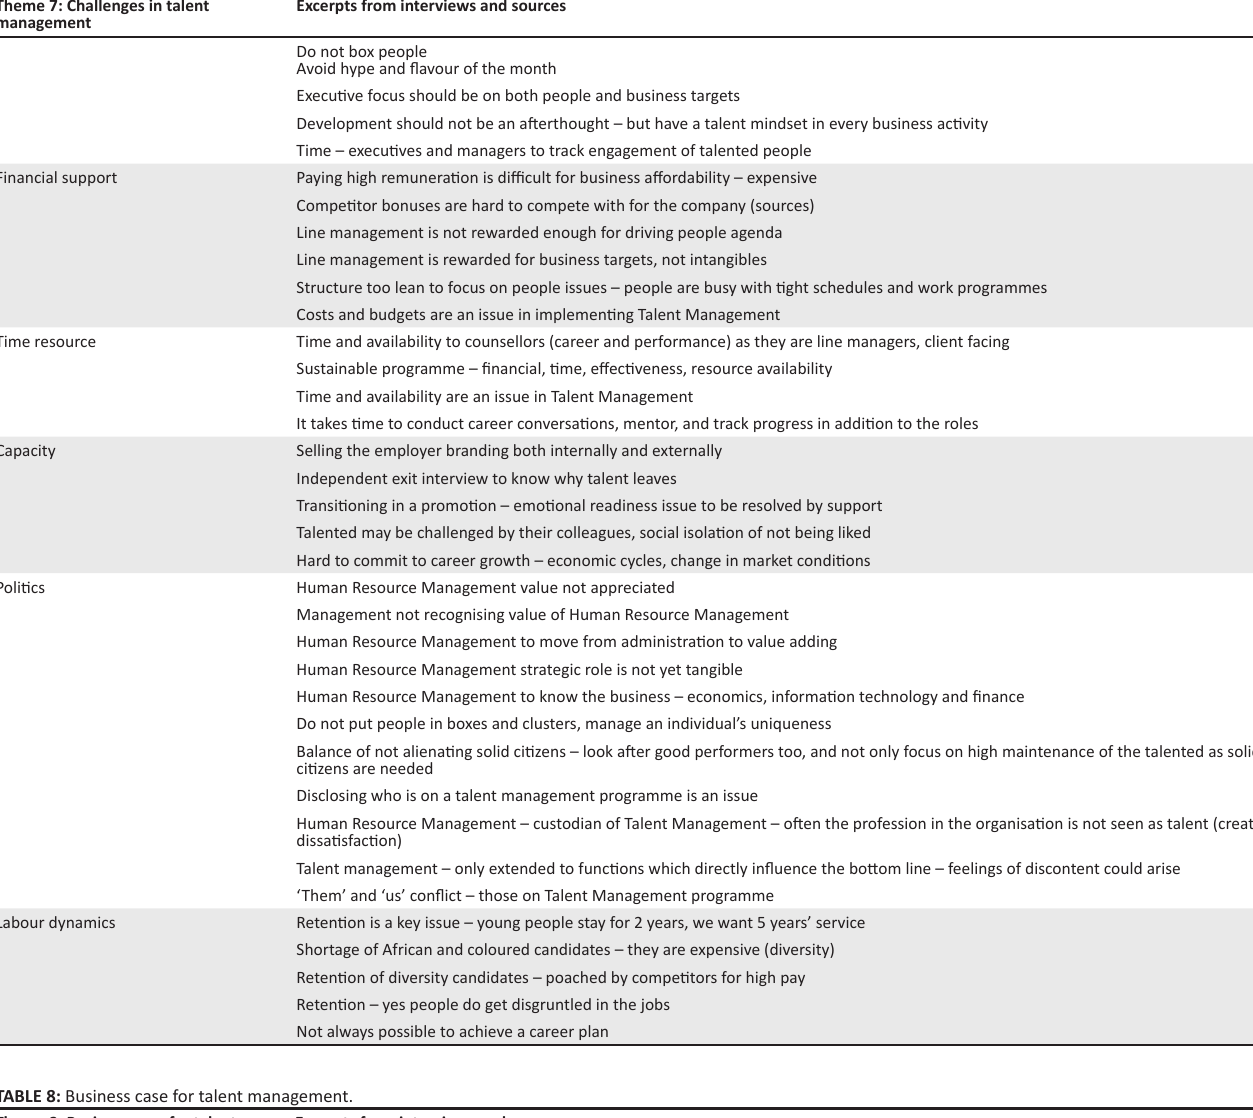
TABLE 7 (Continues...): Challenges in talent management.